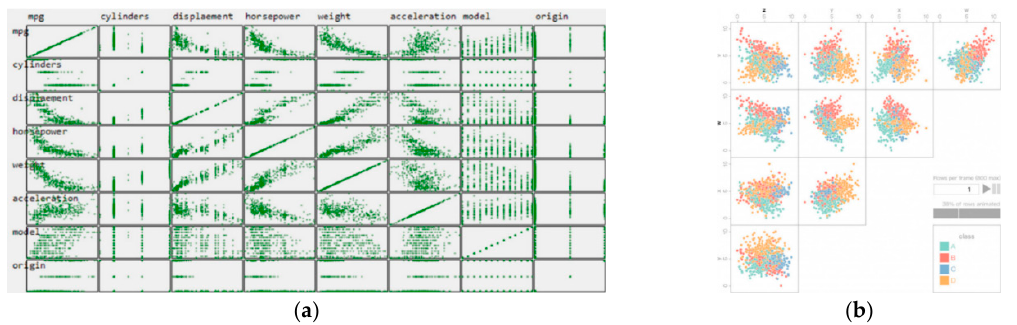
Figure 48. SPLOM visualization examples: ( a ) exploration of a seven-dimensional car dataset [126]; and ( b ) system interface of the flicker-based animated SPLOM [127].